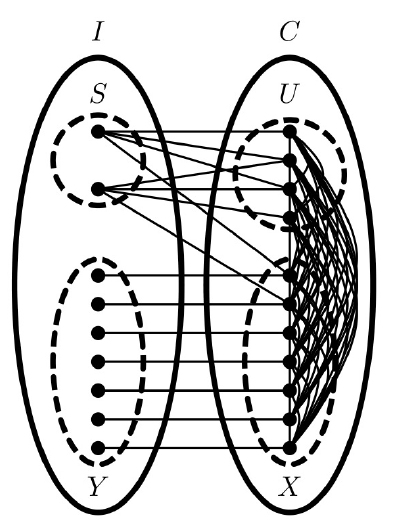
Figure 3. A split graph G with one of its partitions